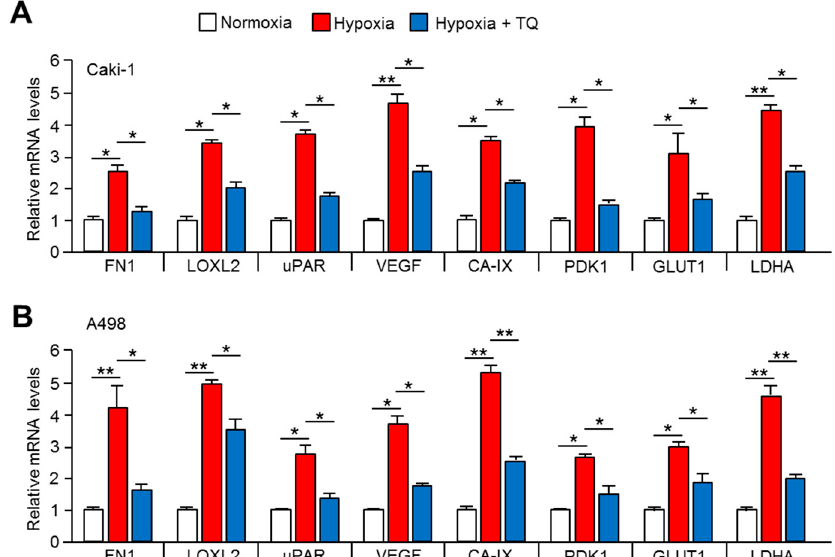
Figure 5. TQ decreases expression of hypoxia-induced HIF-1 α target genes in renal cancer cells. ( A ) Caki-1 and ( B ) A498 cells were incubated under normoxia or hypoxia in the absence or presence of 10 μ M of TQ for 24 h. The values represent the mean ± SD of three independent experiments performed in duplicate; * p < 0.05 and ** p < 0.01.